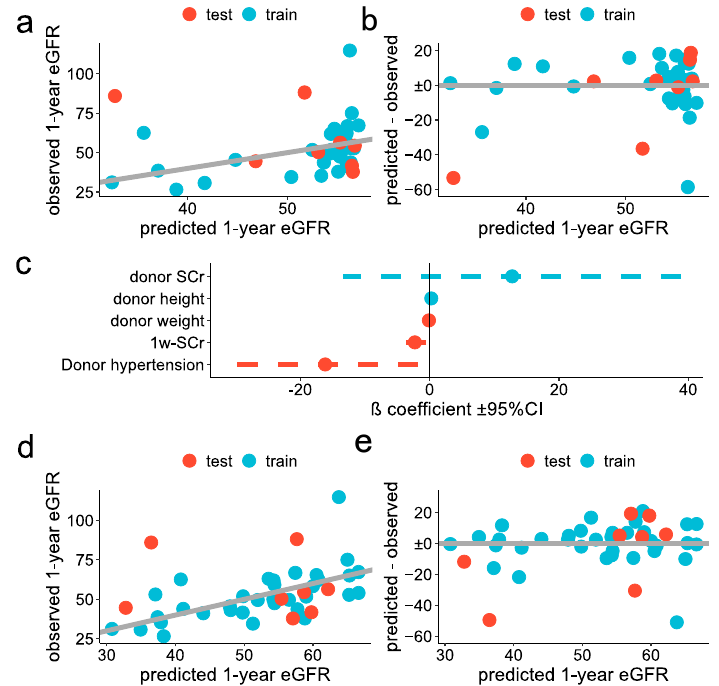
Figure 4. Classic statistical approach for prediction of the one-year eGFR: ( a , b ) Simple model: scatter plot showing the observed ( y -axis) predicted ( x -axis) one-year eGFR, in the test (red) and training (blue) datasets ( a ), scatter plot showing the residuals for each predicted value, in the test (red) and training (blue) datasets ( b ). ( c – e ) stepwise regression: forest plot showing the ß coefficient ±95% confidence interval of each variable selected in the optimal model ( d ), scatter plot showing the ob- served ( y -axis) predicted ( x -axis) one-year eGFR, in the test (red) and training (blue) datasets and ( e ) scatter plot showing the residuals for each predicted one-year eGFR, in the test (red) and training (blue) datasets.